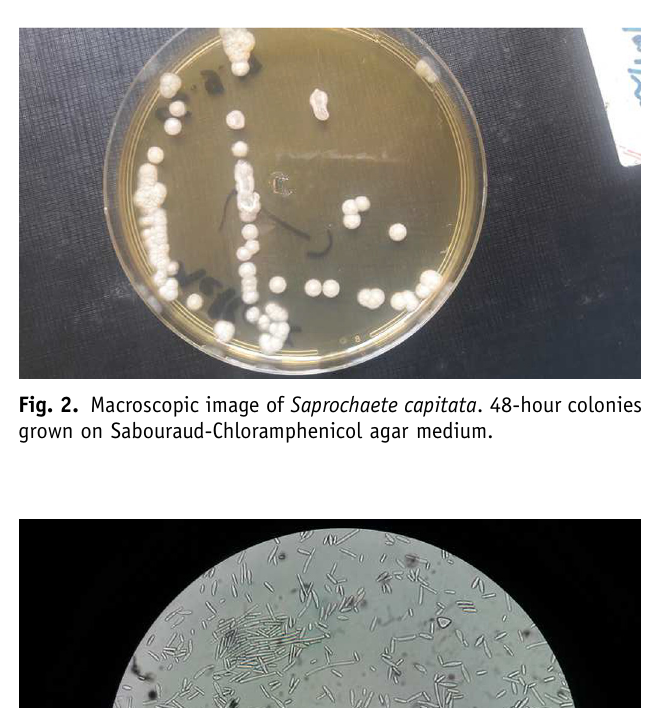
regions for a more formal identi fi cation of the species was not realized due to lack of means.